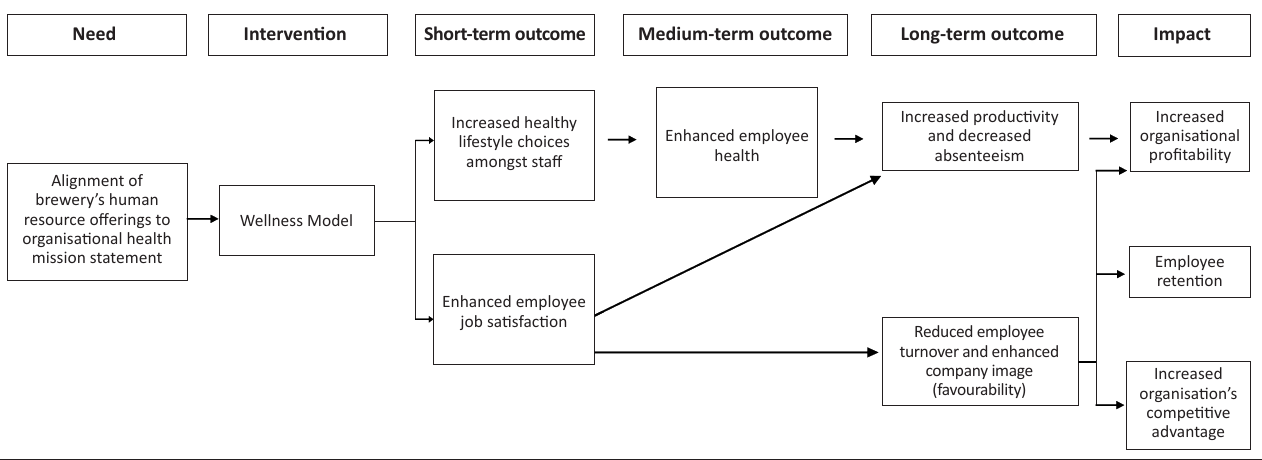
FIGURE 2: Finalised Wellness Model programme